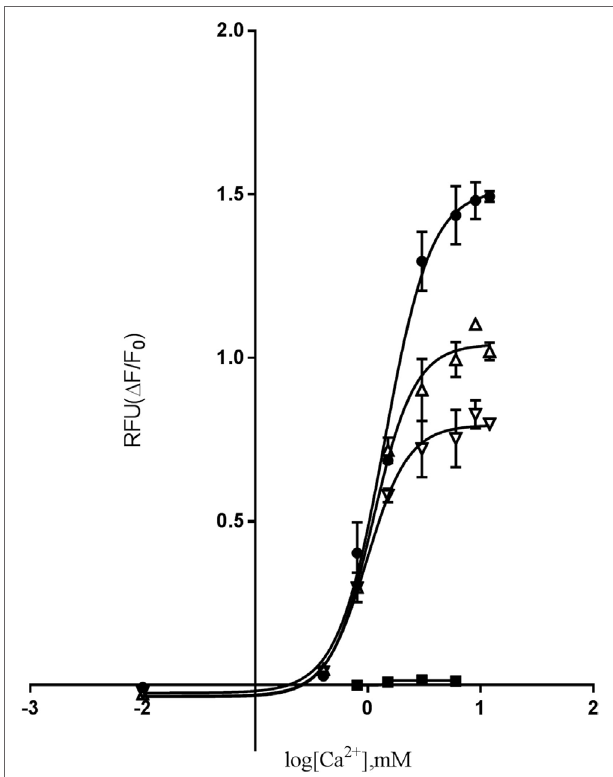
FigUre 4 | The effect of [Ca 2 + ] o -induced (Ca 2 + ) i -mobilization in cells transfected with WT- or mutated calcium-sensing receptor ( CASR ) gene. Dose-response of relative fluorescence units (RFU) of [Ca 2 + ] o -induced (Ca 2 + ) i -mobilization. Flp-IN human embryonic kidney-293 cells were transiently transfected with the wild-type calcium-sensing receptor (WT- CASR ) ( ● ), D126V- CASR ( ▿ ), WT/D126V- CASR ( ▵ ), or mock vector ( ■ ) were incubated with 4 µM fluo-4AM, washed, and (Ca 2 + ) i release was quantified after addition of various concentrations of [Ca 2 + ] o . Data are mean ± SD of a single representative experiment performed in duplicates. Five additional experiments gave similar results.